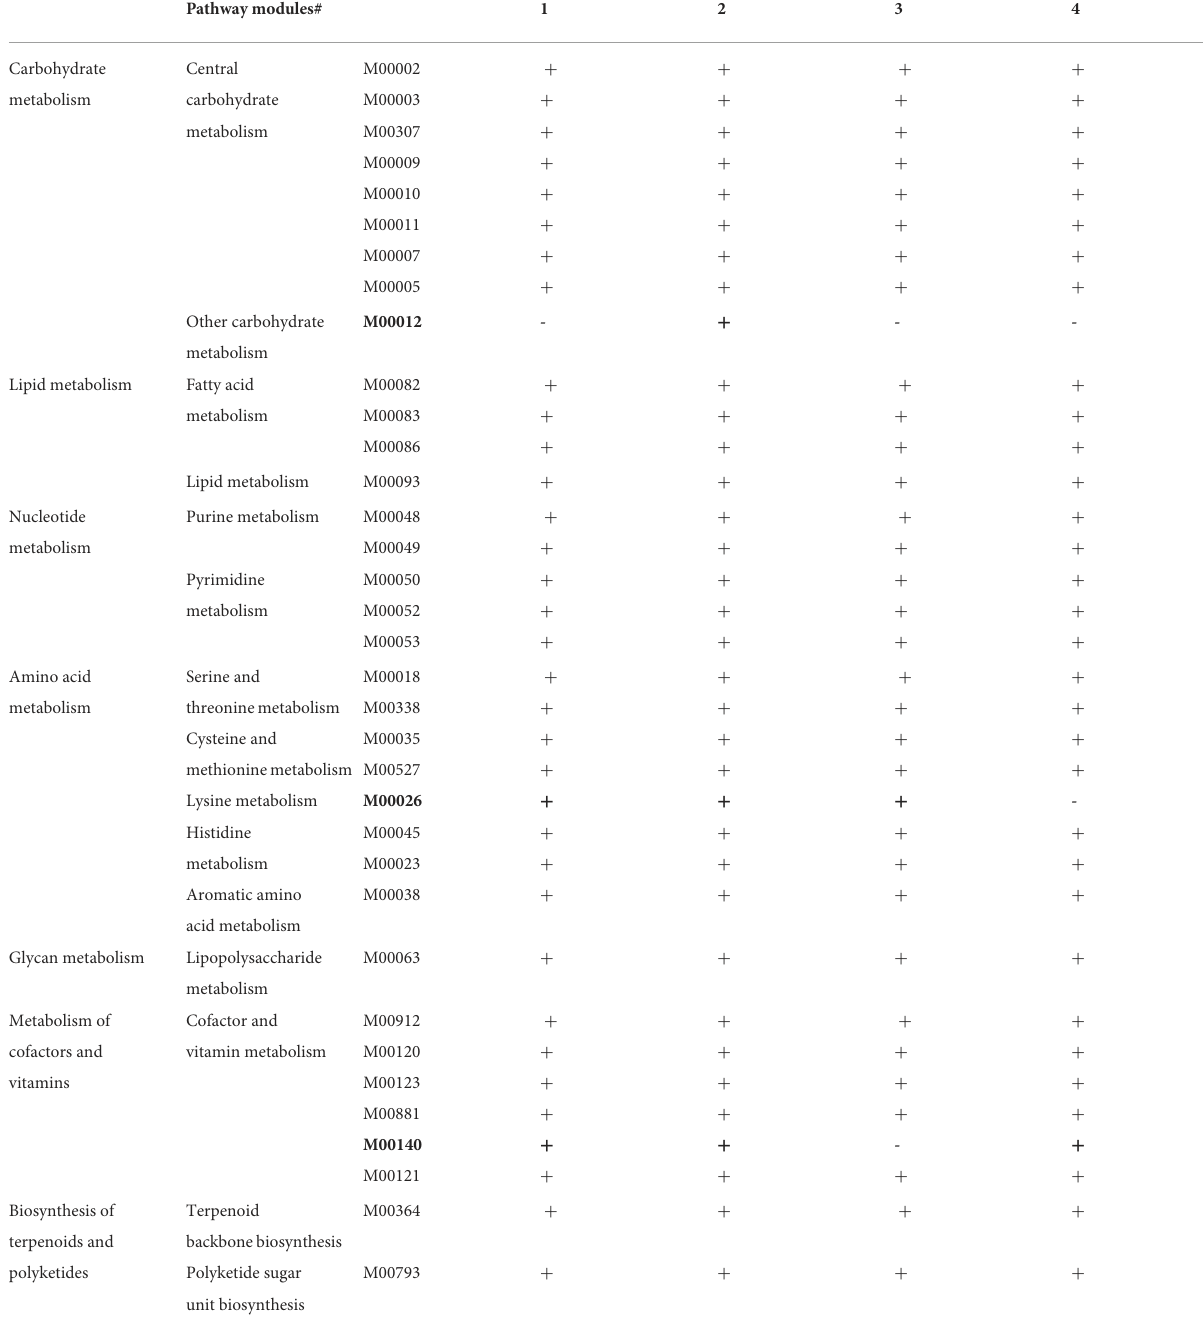
TABLE 4 The comparison of complete and incomplete metabolic pathways in the genomes of strains NBU2968 T , NBU2984 T , and related type strains of the genus Hanstruepera . Pathway modules# Carbohydrate